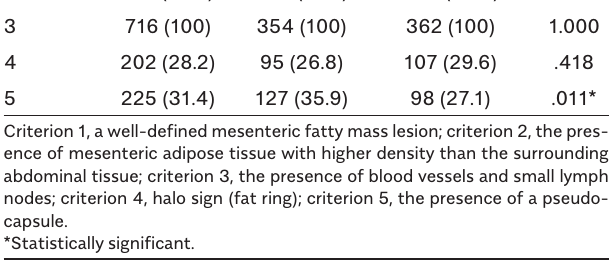
Table 6. The Number of Radiological Criteria in Patients with Mesenteric Panniculitis